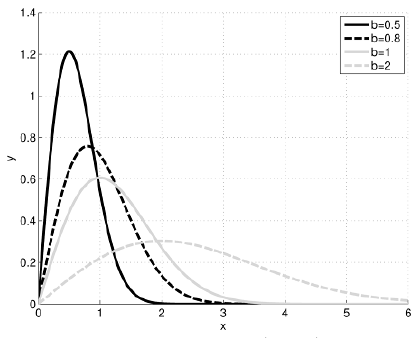
Figure 4. Rayleigh distribution (Eq. 1) for different b